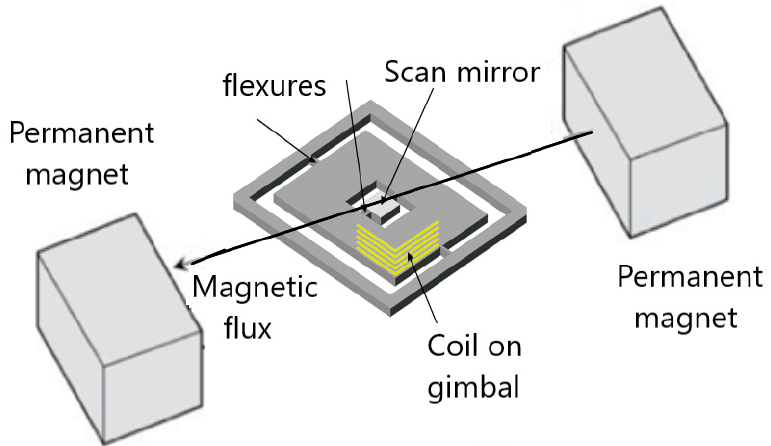
Figure 13. 2D electromagnetic actuator generating the Lorentz force between the micro-coil integrated on the scanner gimbal and the two permanent magnets.